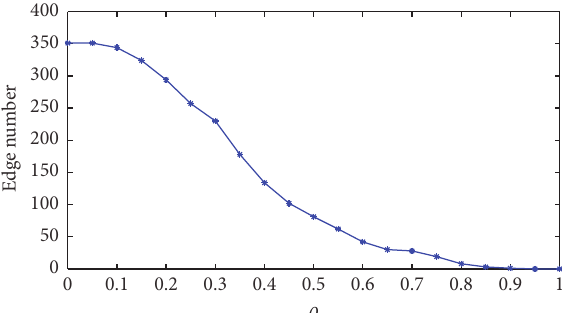
Figure 2: Number of edges at different threshold of the